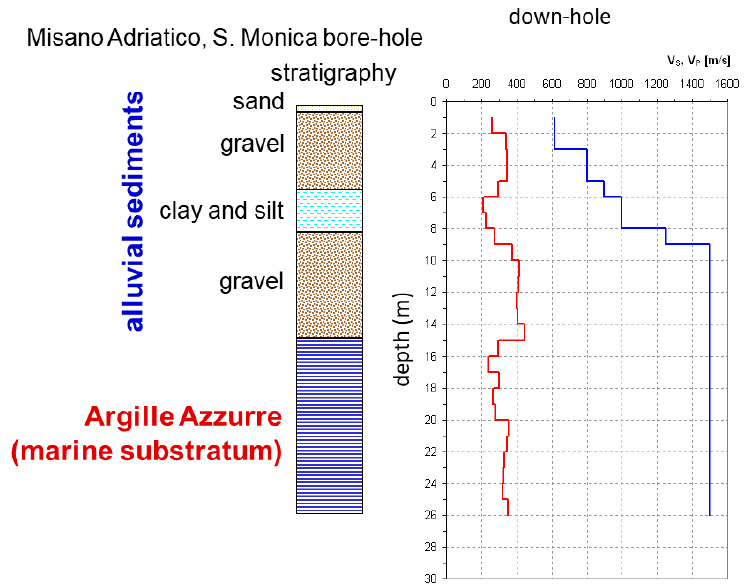
Figure 7. Example of stratigraphic log and Vs-Vp profiles (down-hole) in the foothills area (Santa Monica site, Misano Adriatico Municipality, Rimini Province).